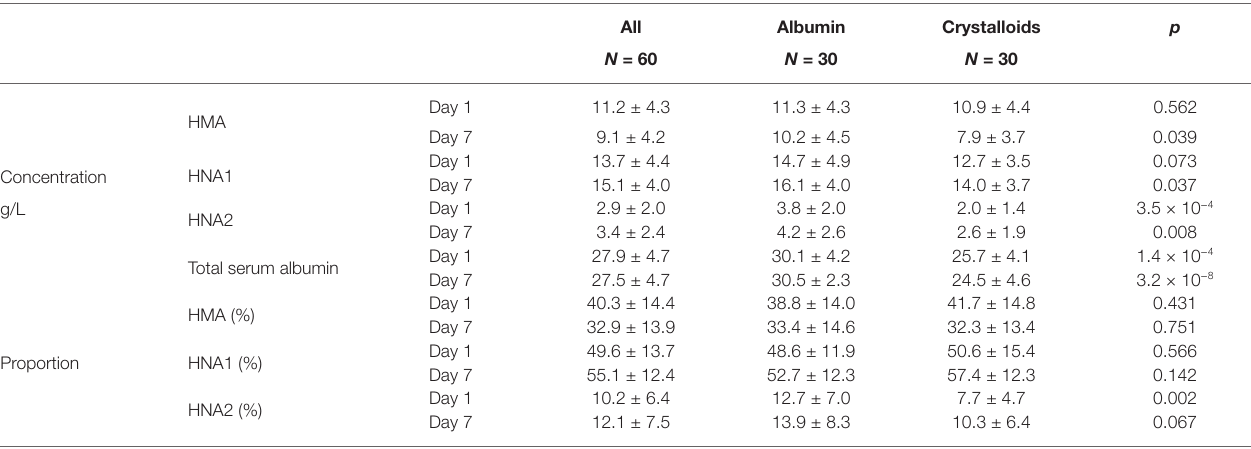
TABLE 2 | Forms of albumin by study treatment on day 1 and 7.